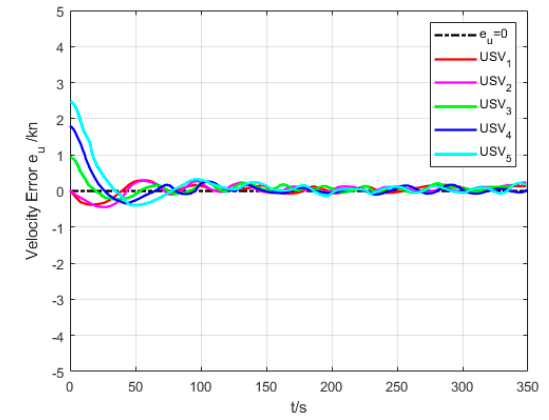
Figure 21. Velocity error (Algorithm 3).